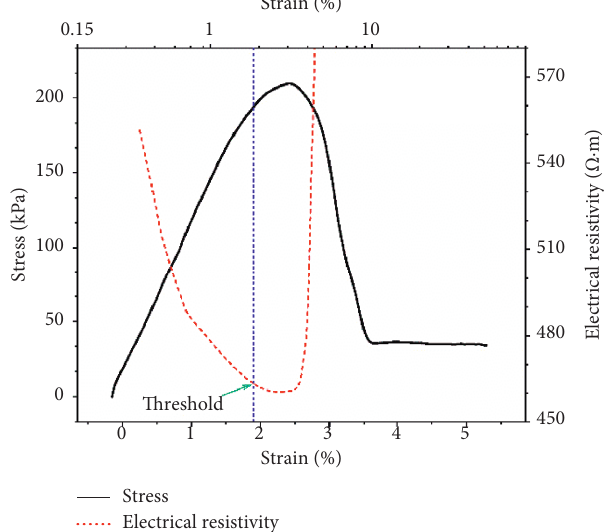
Figure 8: Strain-stress curve and electric resistivity-stress double logarithmic curves of loess.